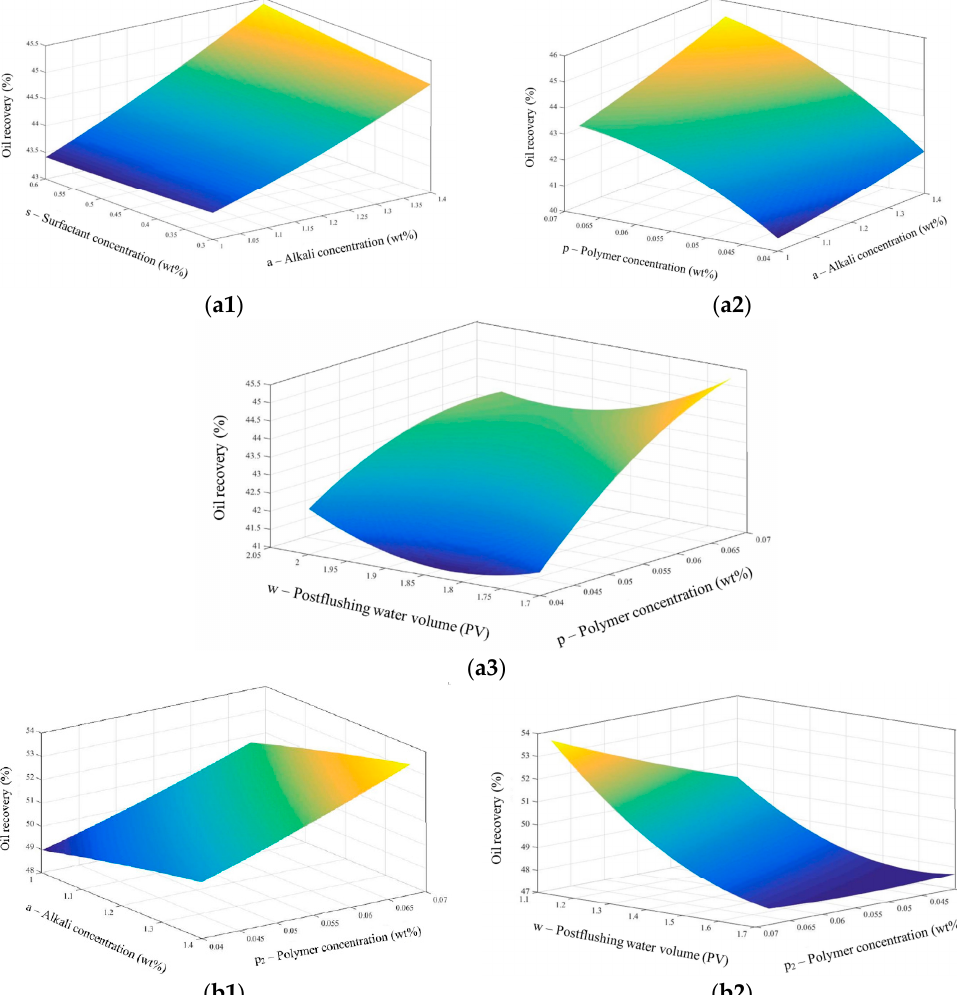
Figure 11. Correlations between the design variables and the response surfaces. W ‐ ASP ‐ W: ( a1 ) a ‐ s vs. RF ; ( a2 ) a ‐ p vs. RF ; ( a3 ) p ‐ w vs. RF . W ‐ ASP ‐ P ‐ W: ( b1 ) a ‐ p 2 vs. RF ; ( b2 ) p 2 ‐ w vs. RF . Within the range